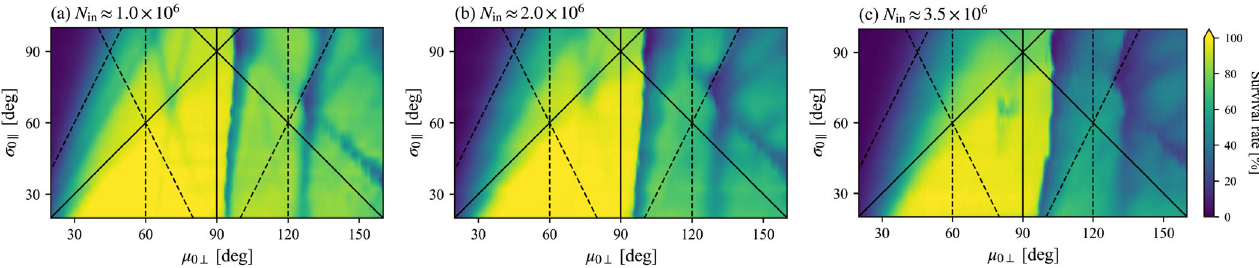
FIG. 6. Stability tune diagram for the ion storage period of 0.5 ms (500 AG cells). The number of ions confined initially in the LPT is adjusted to about (a) 1 . 0 × 10 6 , (b) 2 . 0 × 10 6 , and (c) 3 . 5 × 10 6